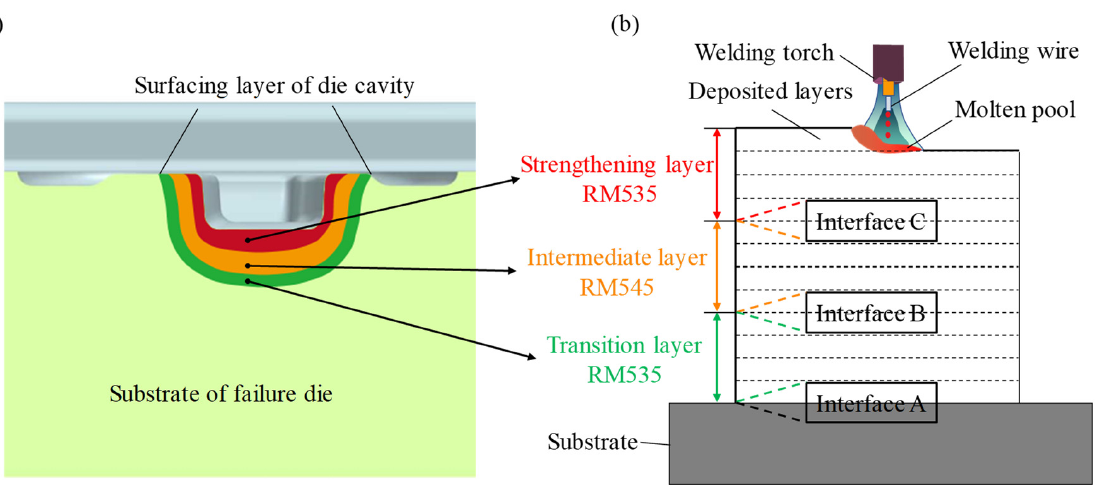
Figure 3. Schematic diagram of multi-material distribution in GAL: ( a ) structural division of the die; ( b ) experiment simplification of GMAW-based additive manufacturing and gradient interfaces of deposited layer. Table 3. Chemical composition (wt.%) of 5CrNiMo steel and additive layers. Table 4. Welding process